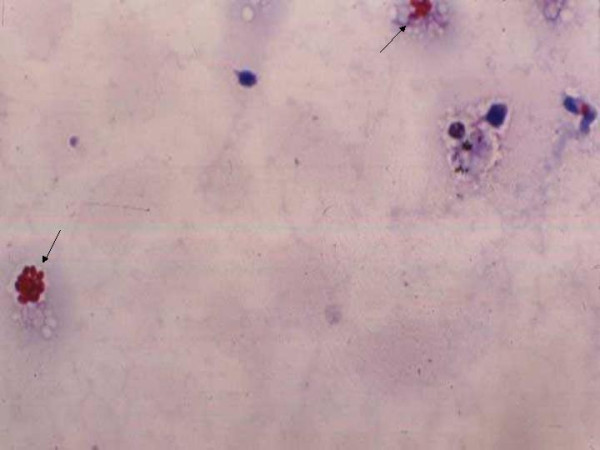
1% acid fast stain of corneal scraping showing acid fast positive oval microsporidial spores (×500, 4b).